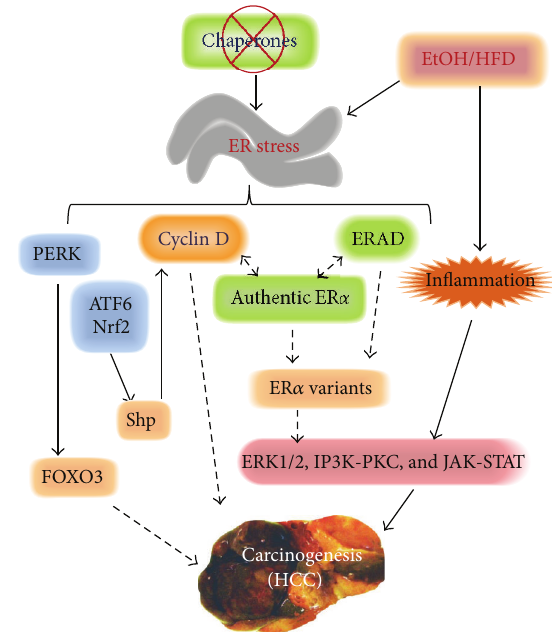
Figure 2: Proposed model depicts novel endoplasmic reticulum (ER) stress mechanisms linking alcohol (EtOH) and/or high-fat diet (HFD), cyclin D, ERAD, estrogen receptor 𝛼 (ER 𝛼 ) variants, FOXO3, and Shp with hepatocellular carcinogenesis (HCC). Solid lines represent established pathways based on the literature; dashed lines represent emerging mechanisms under investigations. See the context for